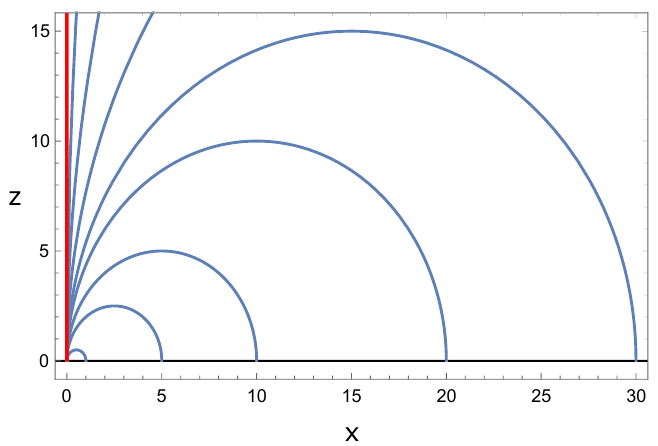
Figure 5 . Ryu-Takayanagi extremal curves for CFT 2 /AdS 3 given by semi-circles z 2 +( x (cid:0) (cid:3)) 2 = (cid:3) 2 with z > 0. In the limit of (cid:3) ! + 1 we see how they limit towards the red vertical line, that is precisely the horizon at t = 0 in the diagram that is on the left of (cid:12)gure